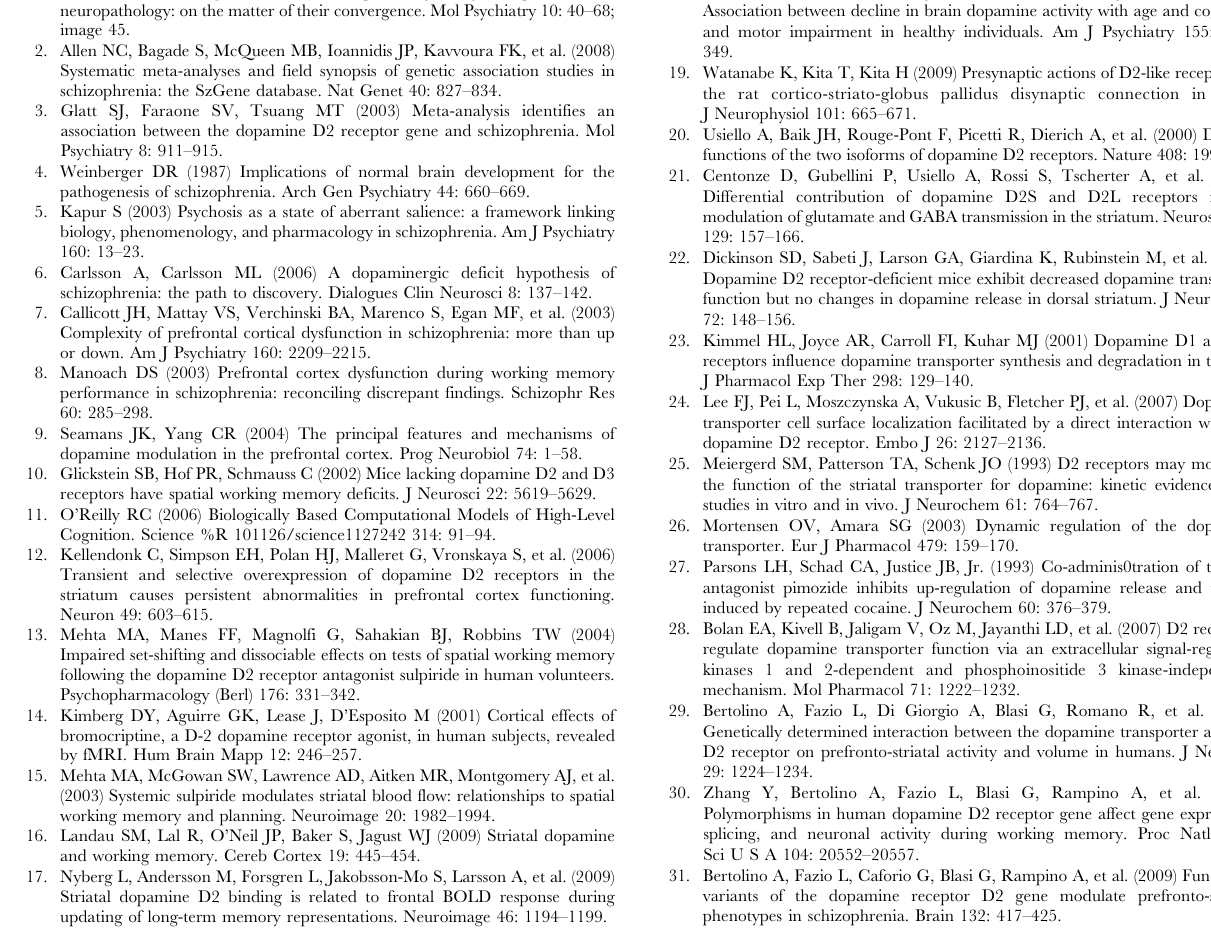
Figure S2 Relationship between behavioral performance and prefrontal activity. Scatterplot of the non-linear relationship in GG subjects between working memory behavioral performance and prefrontal activity during working memory as measured with BOLD